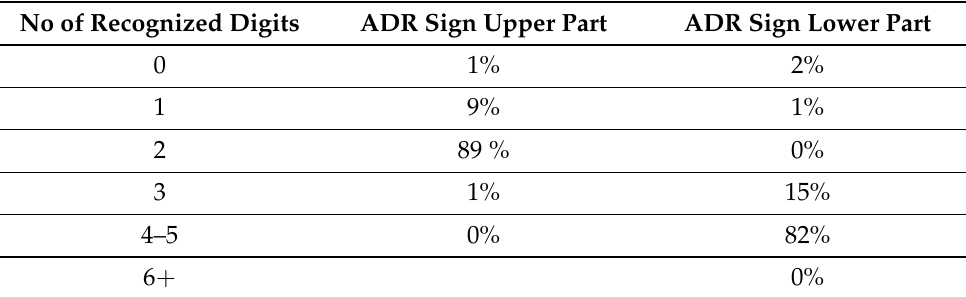
Table 5. Results of the software’s optical character recognition capabilities on the same dataset of 100 photographs of ADR vehicles, after artificially increasing resolution and applying bicubic interpolation. No of Recognized Digits ADR Sign Upper Part